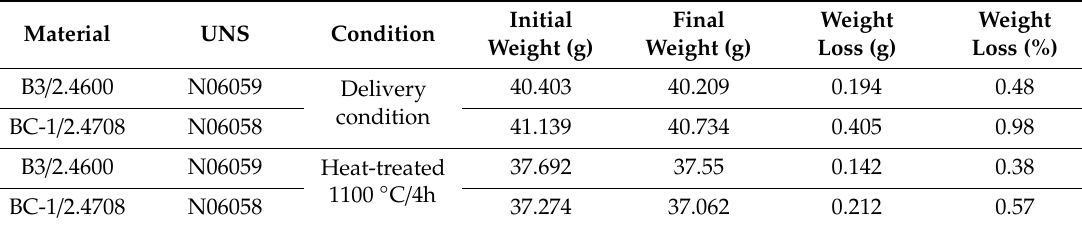
Table 5. Results of corrosion experiments in 95–97% sulfuric acid